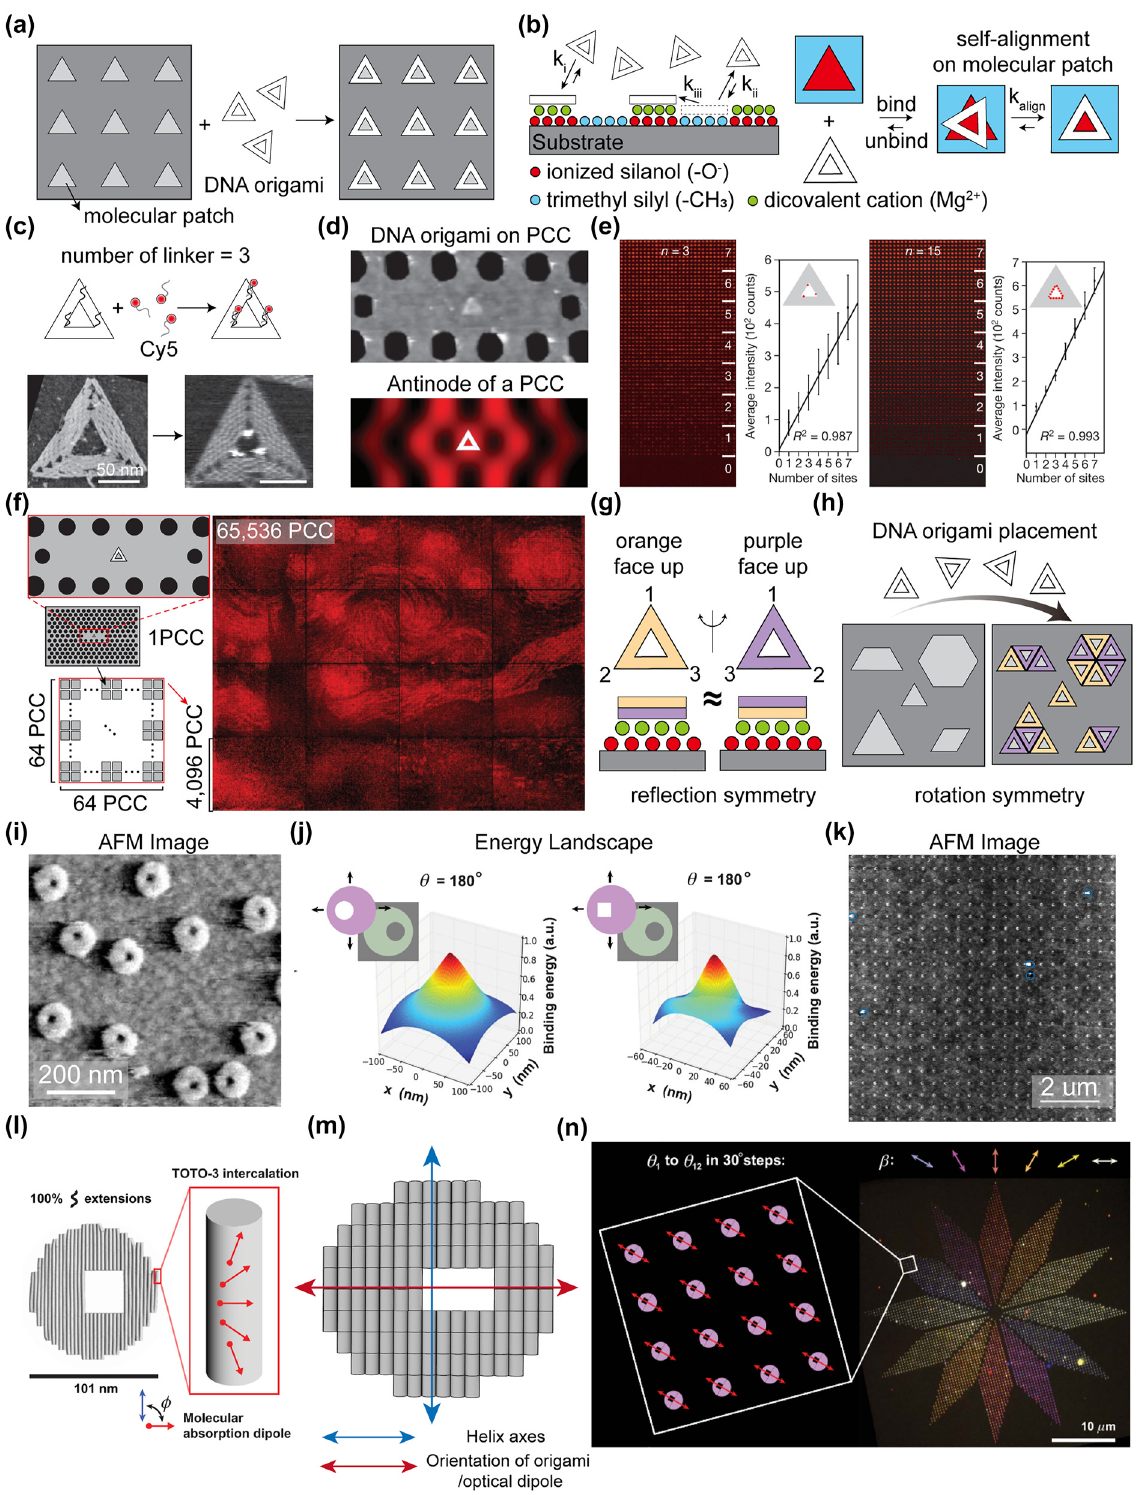
Figure 5: Controlling the molecular position and orientation on wafer-scale area. (a) The molecular patches, which are compatible with the DNA origami sizes and shapes, can roughly guide molecular position and orientation. (b) Left: Magnesium ion mediated DNA origami placement on the binding sites through direct docking (k electron-rich site. Right: The DNA origami lying on a negatively charged patch undergoes self-alignment (k energy. (c) Conjugation of dye molecules on the triangular DNA origami [48]. (d) Cy5-embedded DNA origami placed on antinode of PCC